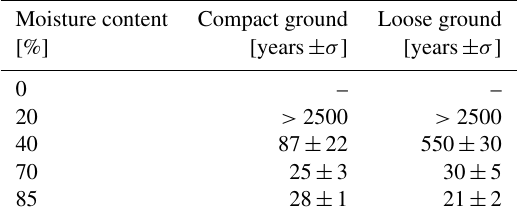
Table 2. Maximum estimated life time in years, assuming a wall thickness of the pipe equal to